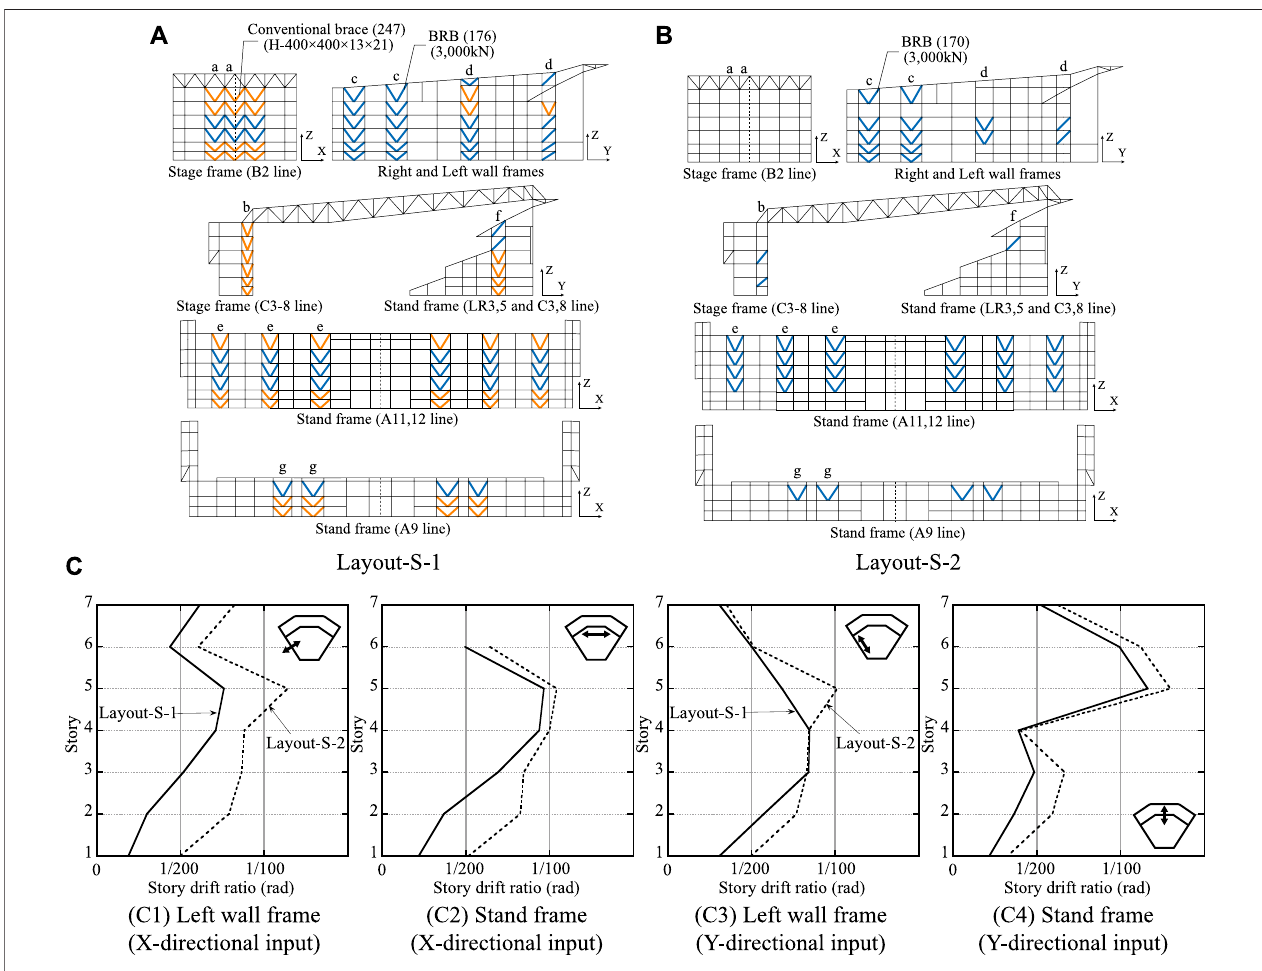
FIGURE 9 | Optimal solution (Layout-S-1 and Layout-S-2): (A) and (B) Optimal placement, (C) Maximum story drift ratio.